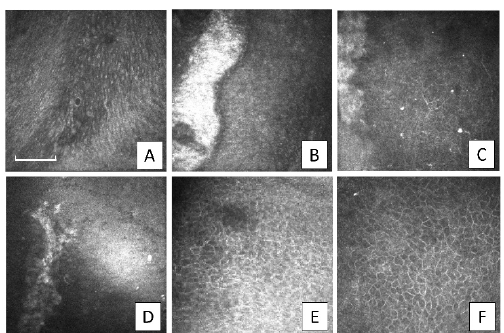
Figure 3. In Vivo Confocal Microscopy (IVCM) details of the evolution of a transplanted sclerocorneal piece after Simple Limbal Epithelial Transplantation (SLET) in the same patient of Figure 2. ( A ) Preoperative appearance of the basal conjunctivalized cells lying on the cornea. ( B ) Small hyper-reflective limbal biopsy fragment at 1-month postoperative, surrounded by small cells with scarcely distinguishable borders. ( C ) At 2-months, the same limbal fragment appeared attenuated with jagged margins. ( D ) At 3-months, it was barely visible. ( E ) At 6-months, the limbal fragment completely disappeared and clear corneal epithelium was detected. ( F ) At 12-months, the result was maintained (representative results from patient no. 10; images are 400 × 400 µm, the bar is 100 µm). Starting from the 3-month follow-up after SLET, the renewing corneal epithelial cells appeared with indistinct borders, bright nuclei, and a high nucleus-to-cytoplasm ratio (Figure 4A). Thereafter, we observed an intact corneal epithelium represented by cells exhibiting a normal corneal phenotype. At the 5-month postoperative evaluation after SLET, a multi-layered epithelium with corneal phenotype was detected in the central cornea in eight out of 10 patients.